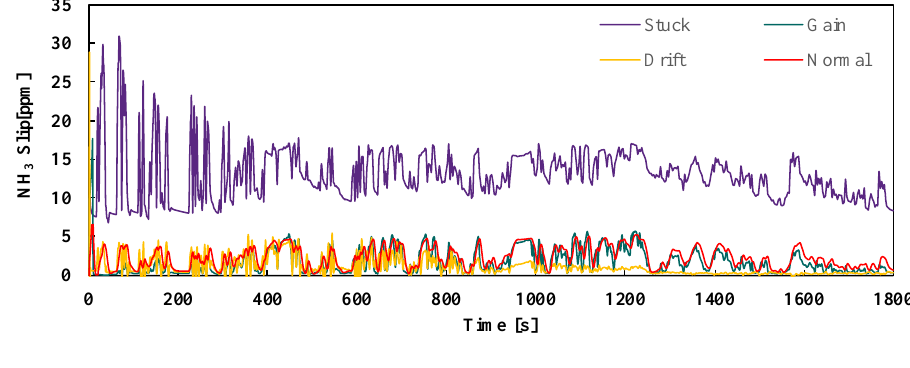
Figure 10. NH 3 slip vs. time.